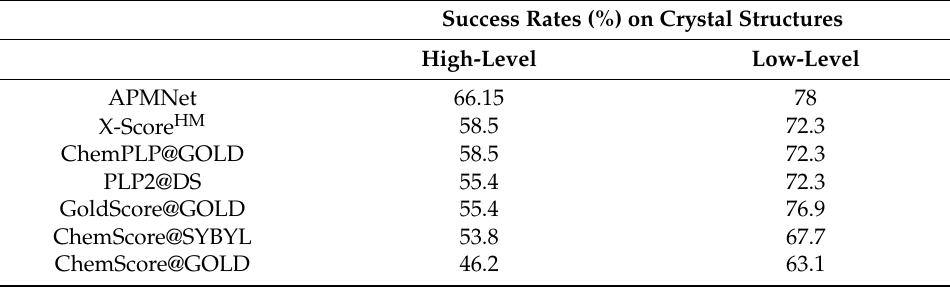
Table 4. Performance comparison of different methods in the ranking power